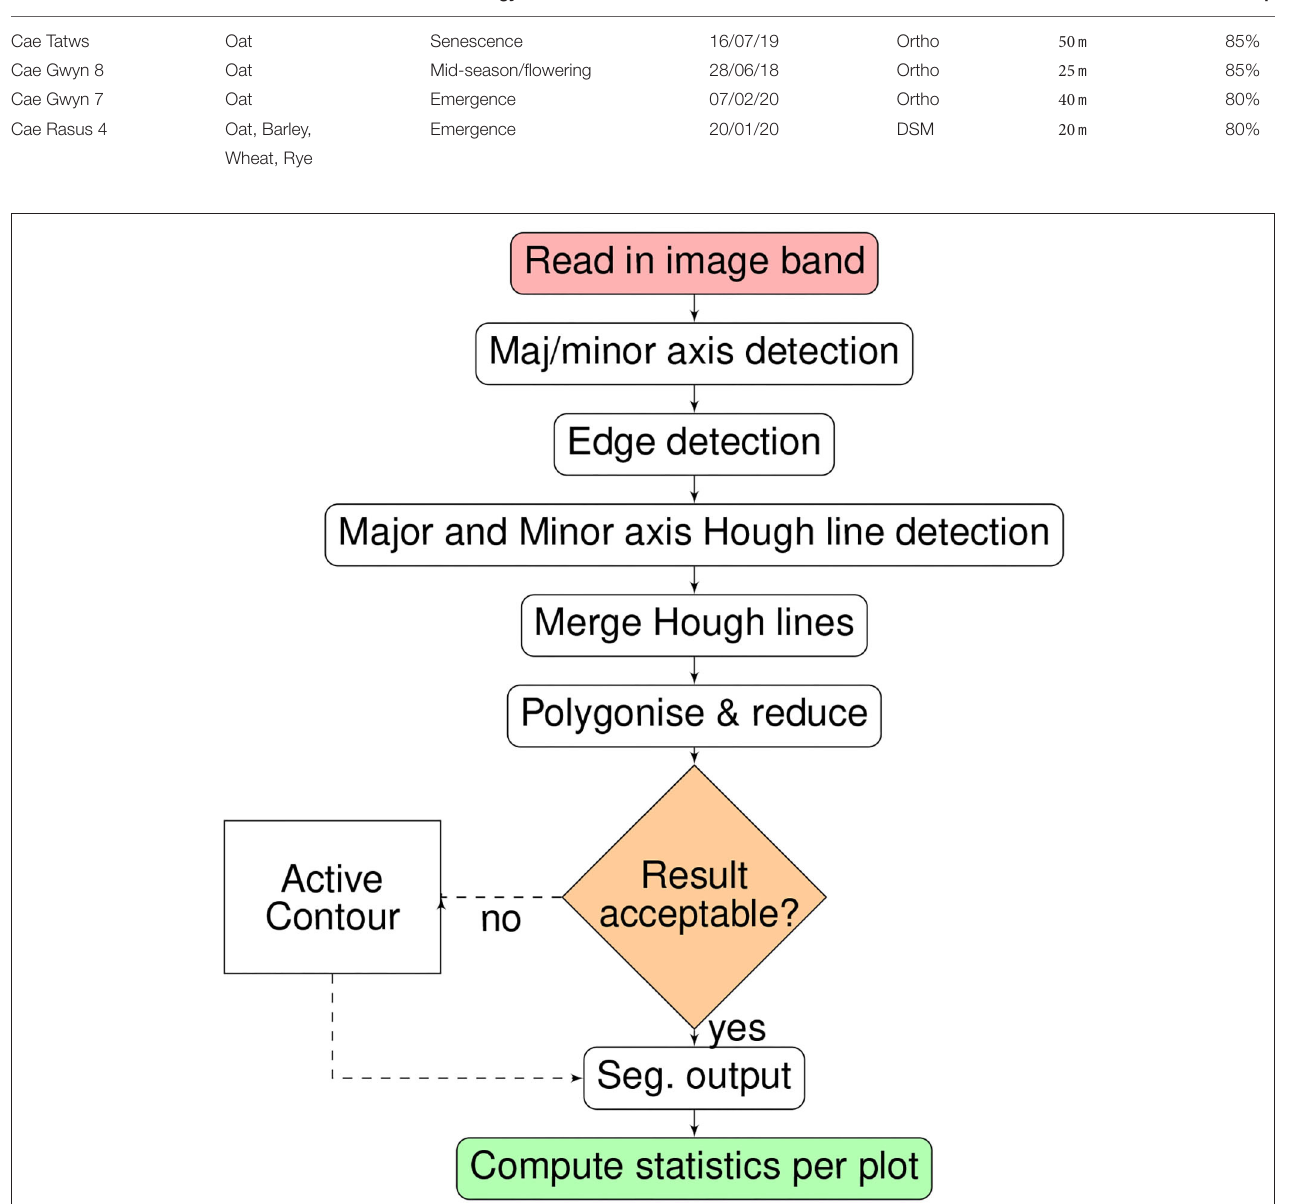
FIGURE 2 | Flow chart summary of the crop segmentation processing